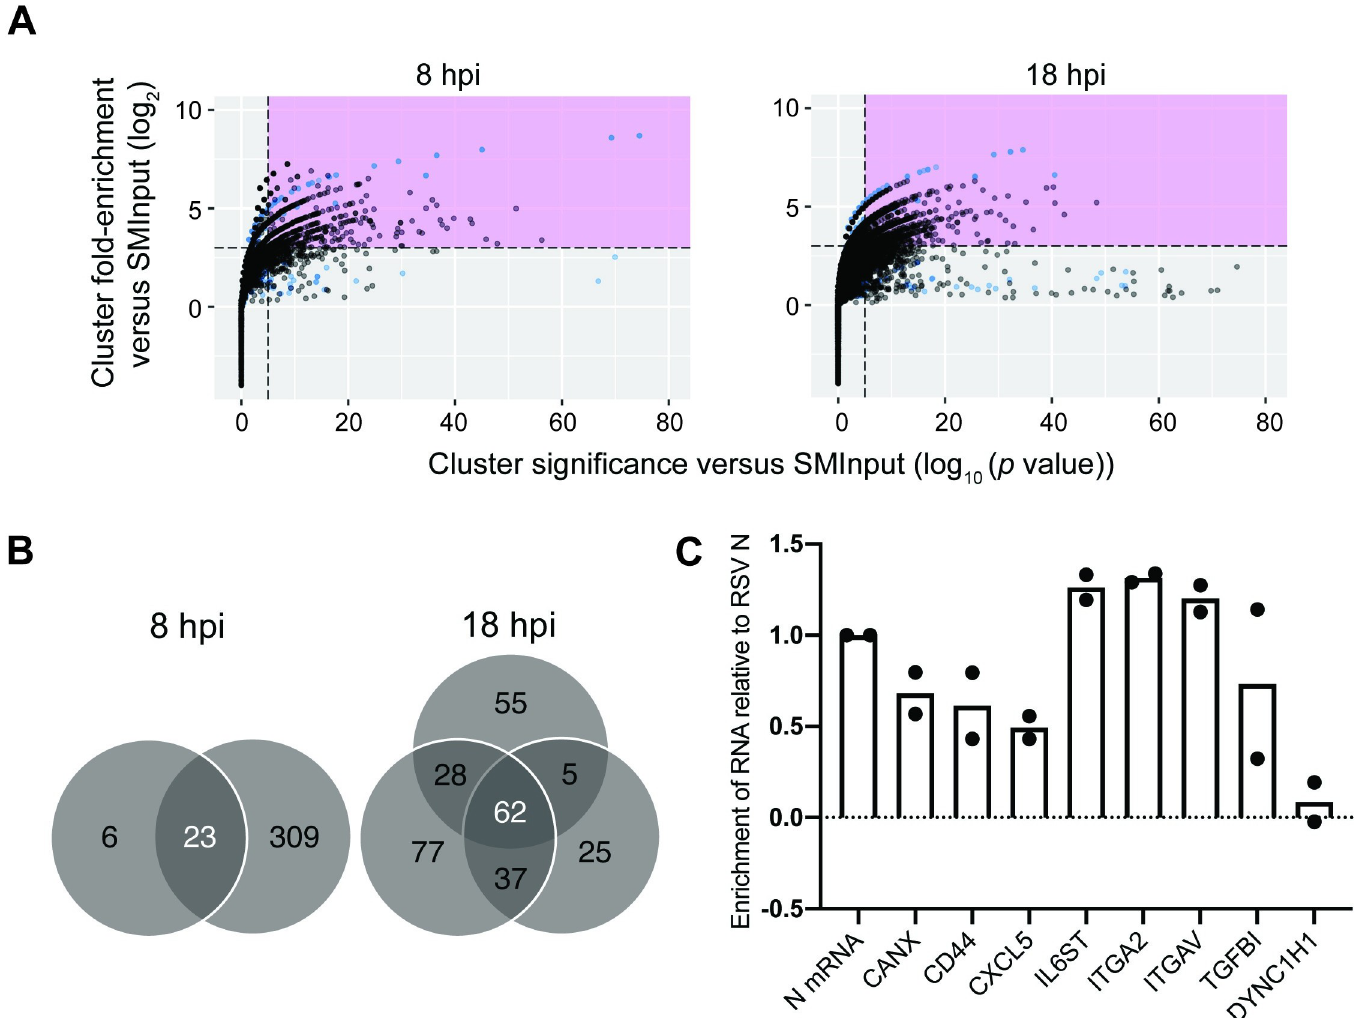
Fig 8. M2-1 binds specifically to host cell RNA. (A) CLIPper-identified peaks were graphed for fold enrichment vs significance using ggplot2. Peaks within the region identified in pink were considered significant based on eCLIP standards. All peaks were plotted from each sample for 8 and 18 hpi for RSV infected (black) and mock infected (blue). (B) Gene identities of significant peaks were determined and common genes between samples were identified. (C) RNA immunoprecipitation followed by RT-qPCR of target genes identified by CLIPper. Levels of co-immunoprecipitated RNA were normalized to levels of co-immunoprecipitated N mRNA. Individual data points for two biological replicate experiments are